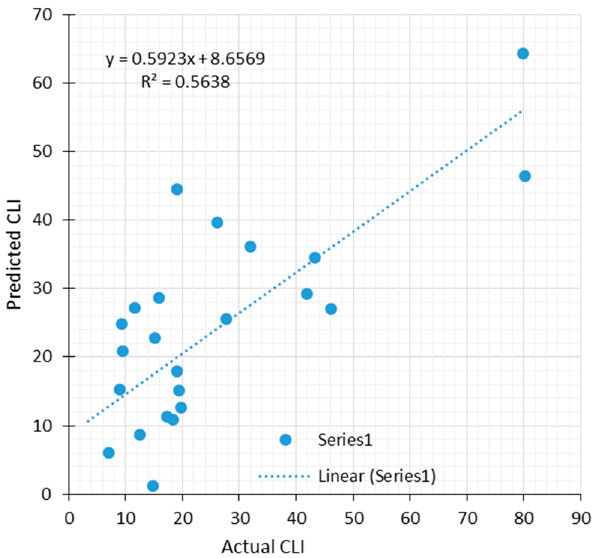
Figure 23. Relations between the actual CLI and estimated CLI by FL model 1 for testing.